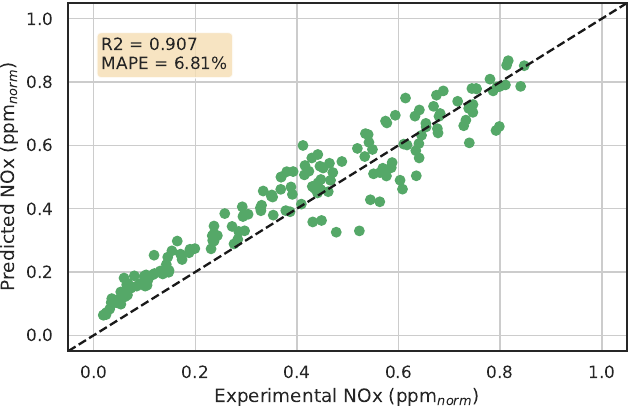
Figure 17. Correlation between experimental and predicted NOx under engine steady-state operations.